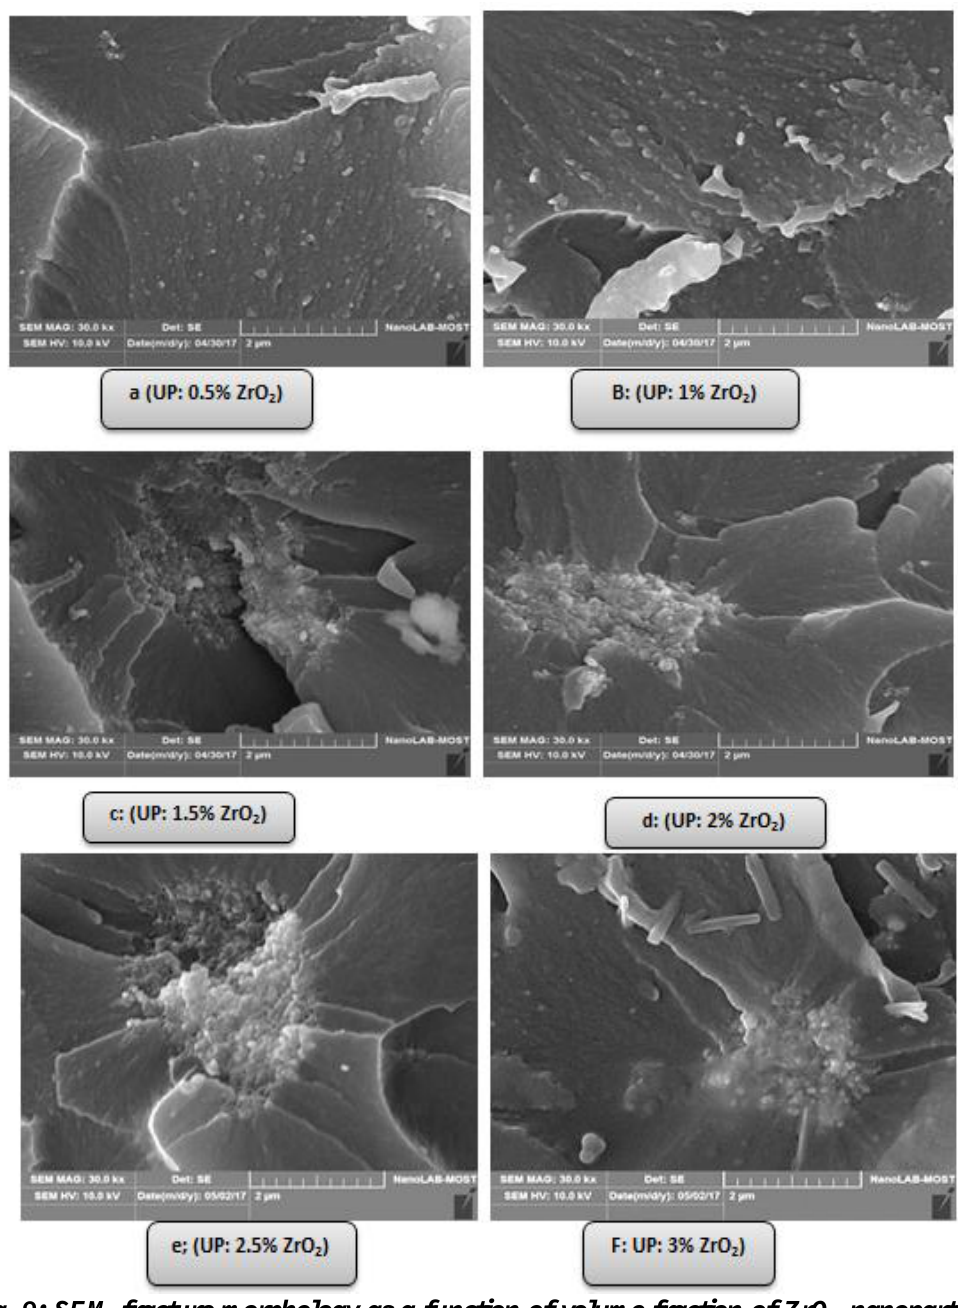
Fig. 9: SEM fracture morphology as a function of volume fraction of ZrO content in the composites, where: (a (x= 0.5%), (b (x = 1%), (c (x= 1.5%), (d (x=2%) (e=2.5%) and (f (x= 3%) at the magnification of (30000